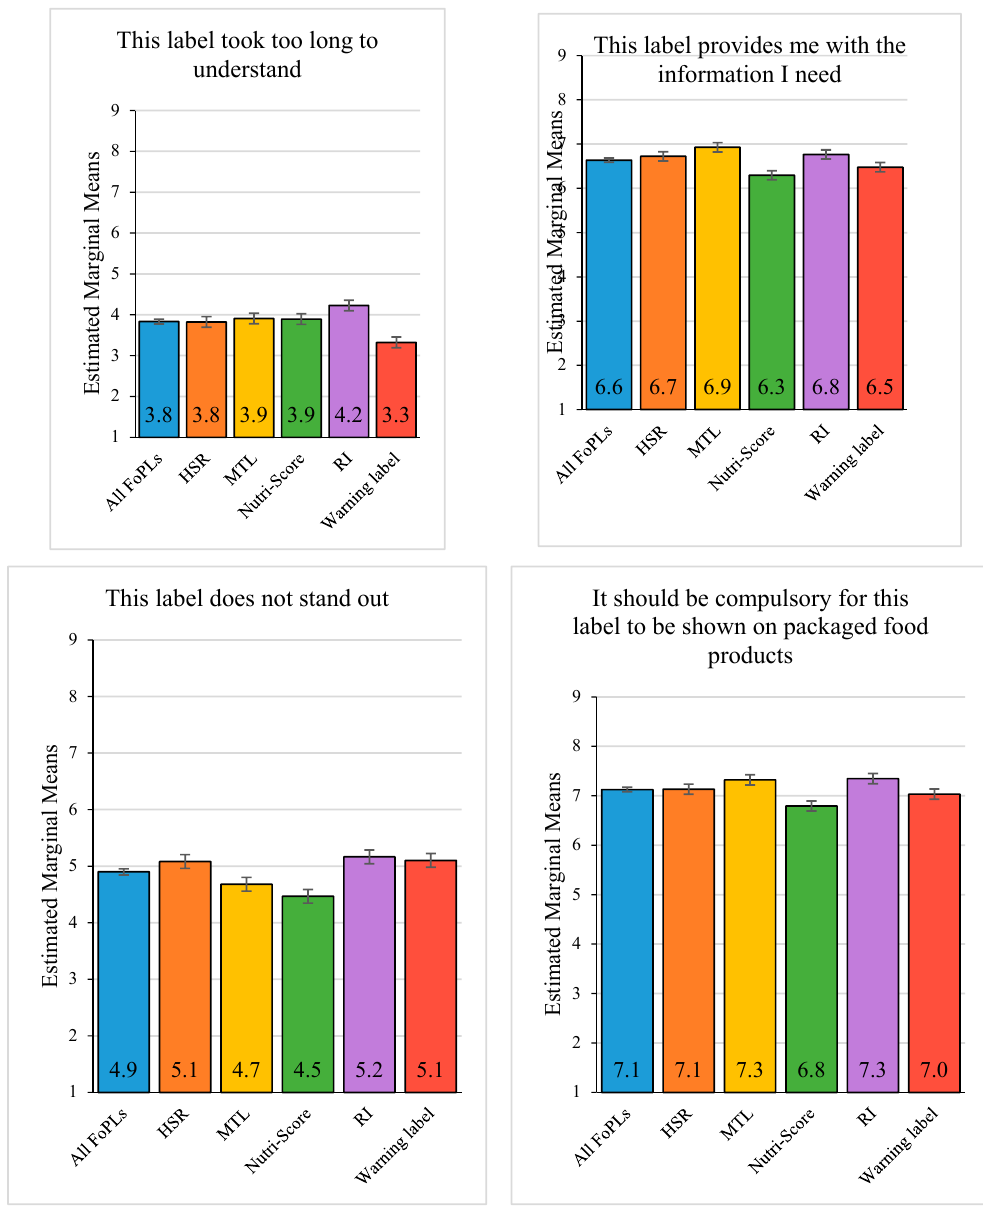
Figure 2. Mean scores across perception items for all FoPLs combined and individually. Note: Graphs show estimated marginal means for FoPL condition adjusted for age, gender, socioeconomic status, grocery buyer status, level of education, diet and nutrition knowledge. Error bars show 99% confidence intervals. HSR = Health Star Rating, MTL = Multiple Traffic Lights, RI = Reference Intakes.